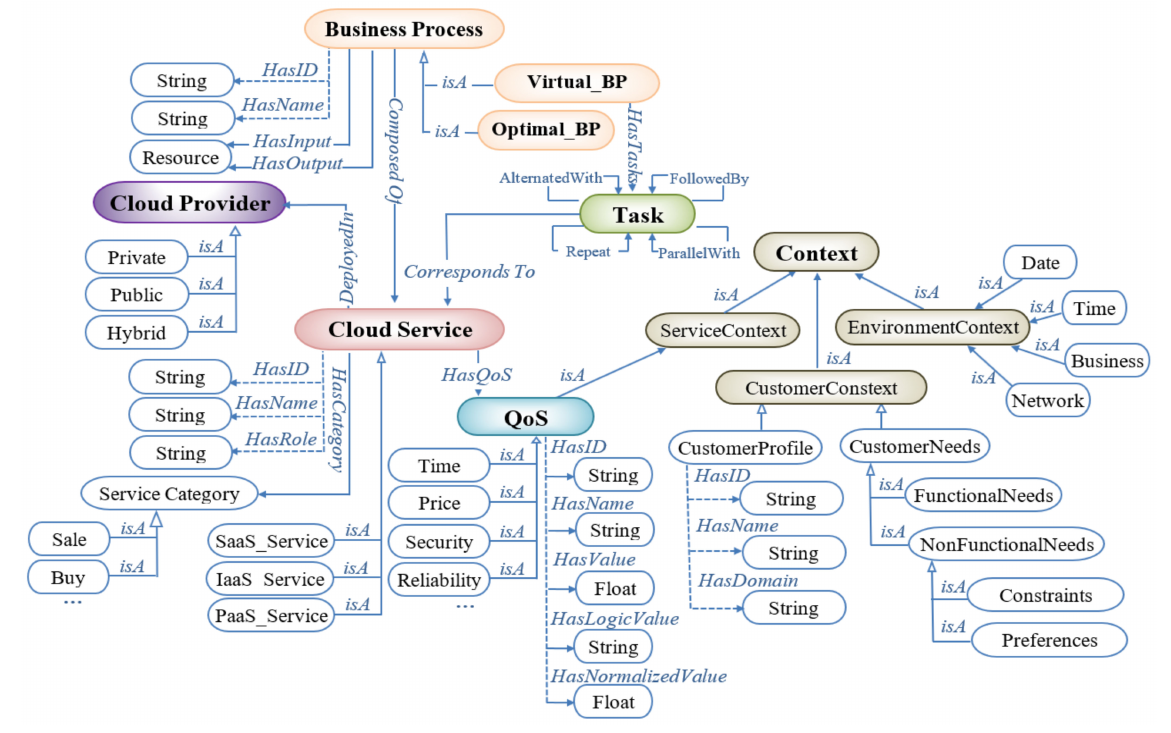
Figure 3. CxQSCloudSERP Ontology model.